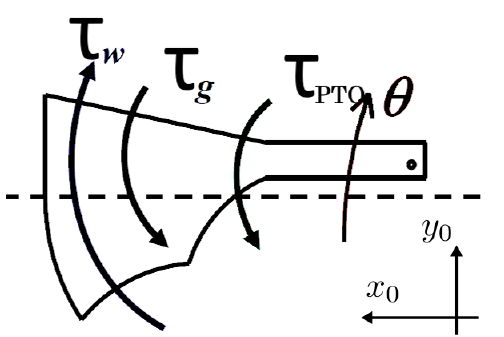
Figure 5. FBD showing the different forces working on the